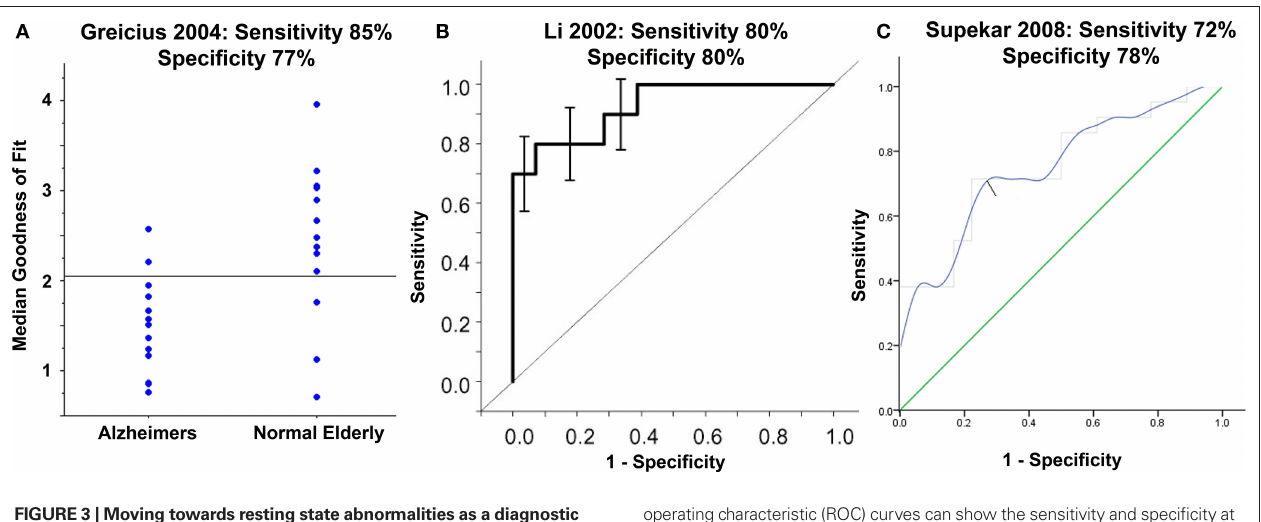
FIguRe 3 | Moving towards resting state abnormalities as a diagnostic marker in Alzheimers: using parameters derived from resting state functional connectivity and choosing an appropriate threshold one can show good segregation between patients with Alzheimers disease (AD) and healthy elderly (A). Instead of picking just one threshold, receiver